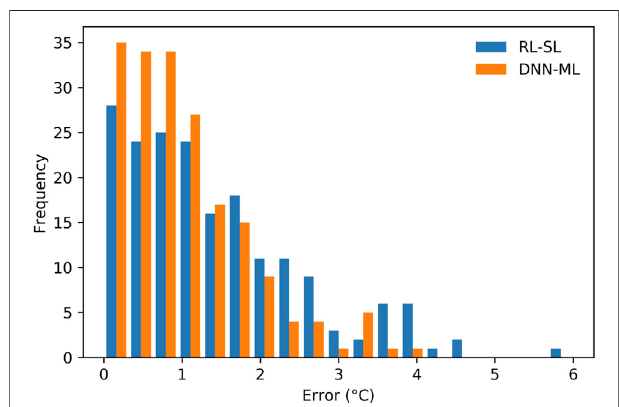
FIGURE 6 | Histograms showing the absolute errors frequency distributions for the single-layer LR and multilayer DNN models in the testing